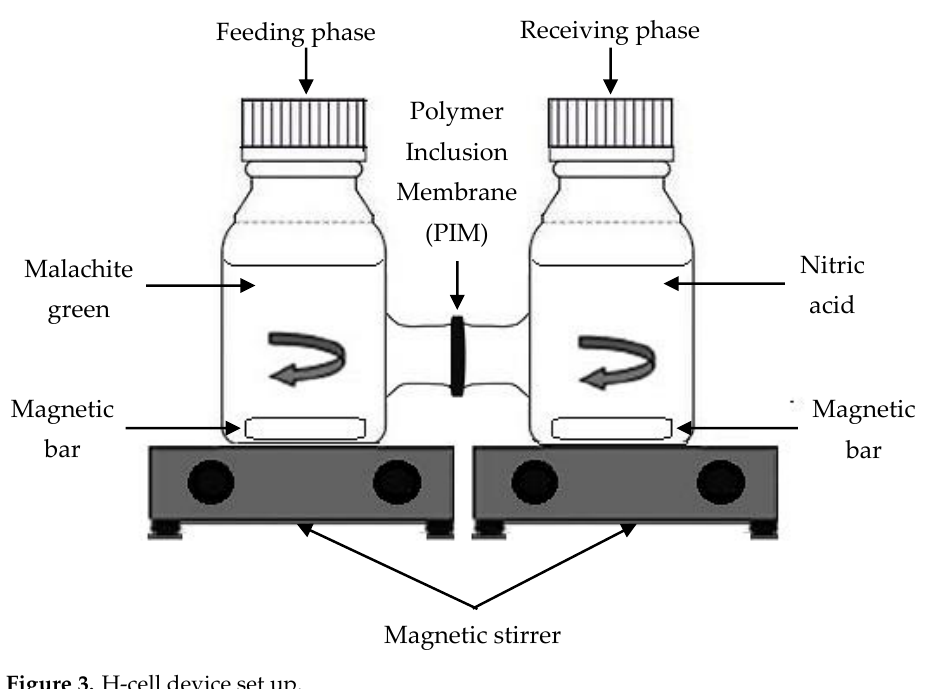
Figure 3. H-cell device set up.